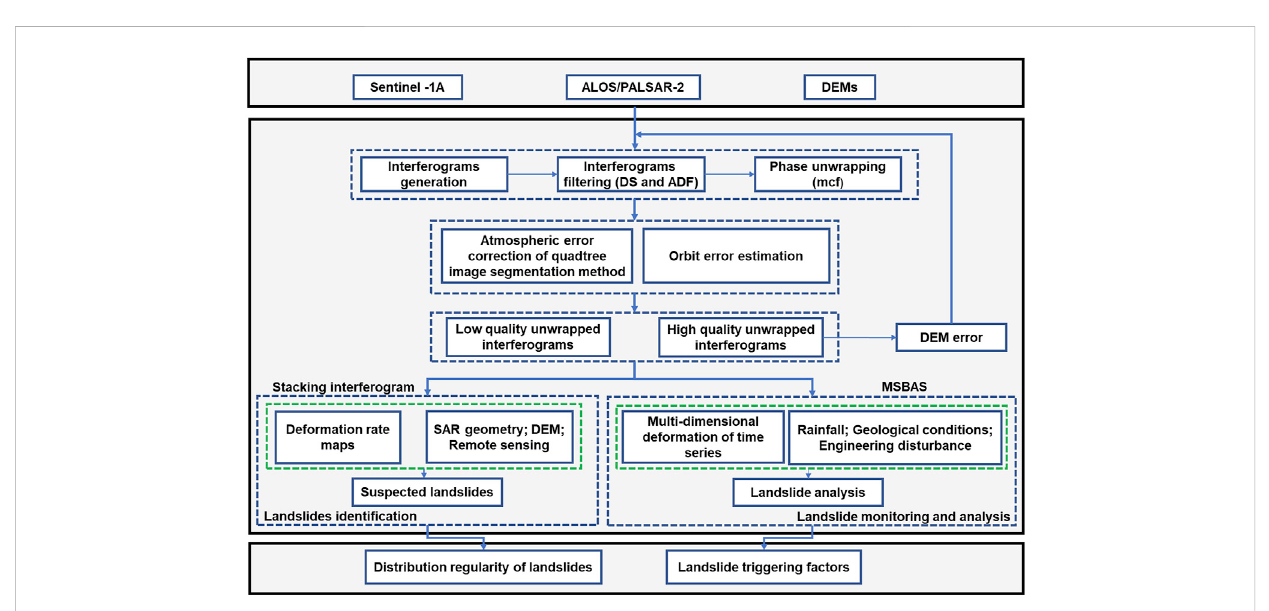
FIGURE 4 Flowchart for the active landslide identi fi cation and deformation